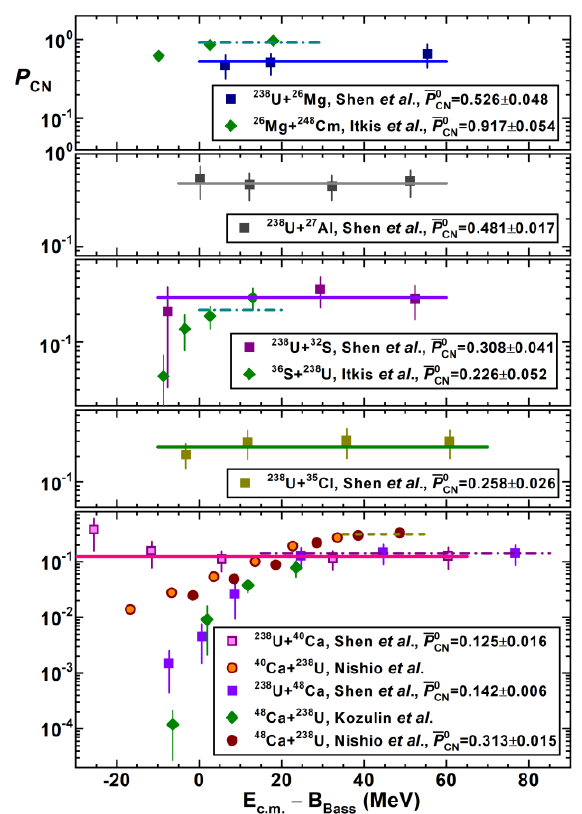
Fig. 2. The same as in Fig. 1 but in the cases of the interaction of 238 U with the Mg to Ca target nuclei and for the 40,48 Ca+ 238 U and 26 Mg+ 248 Cm reactions